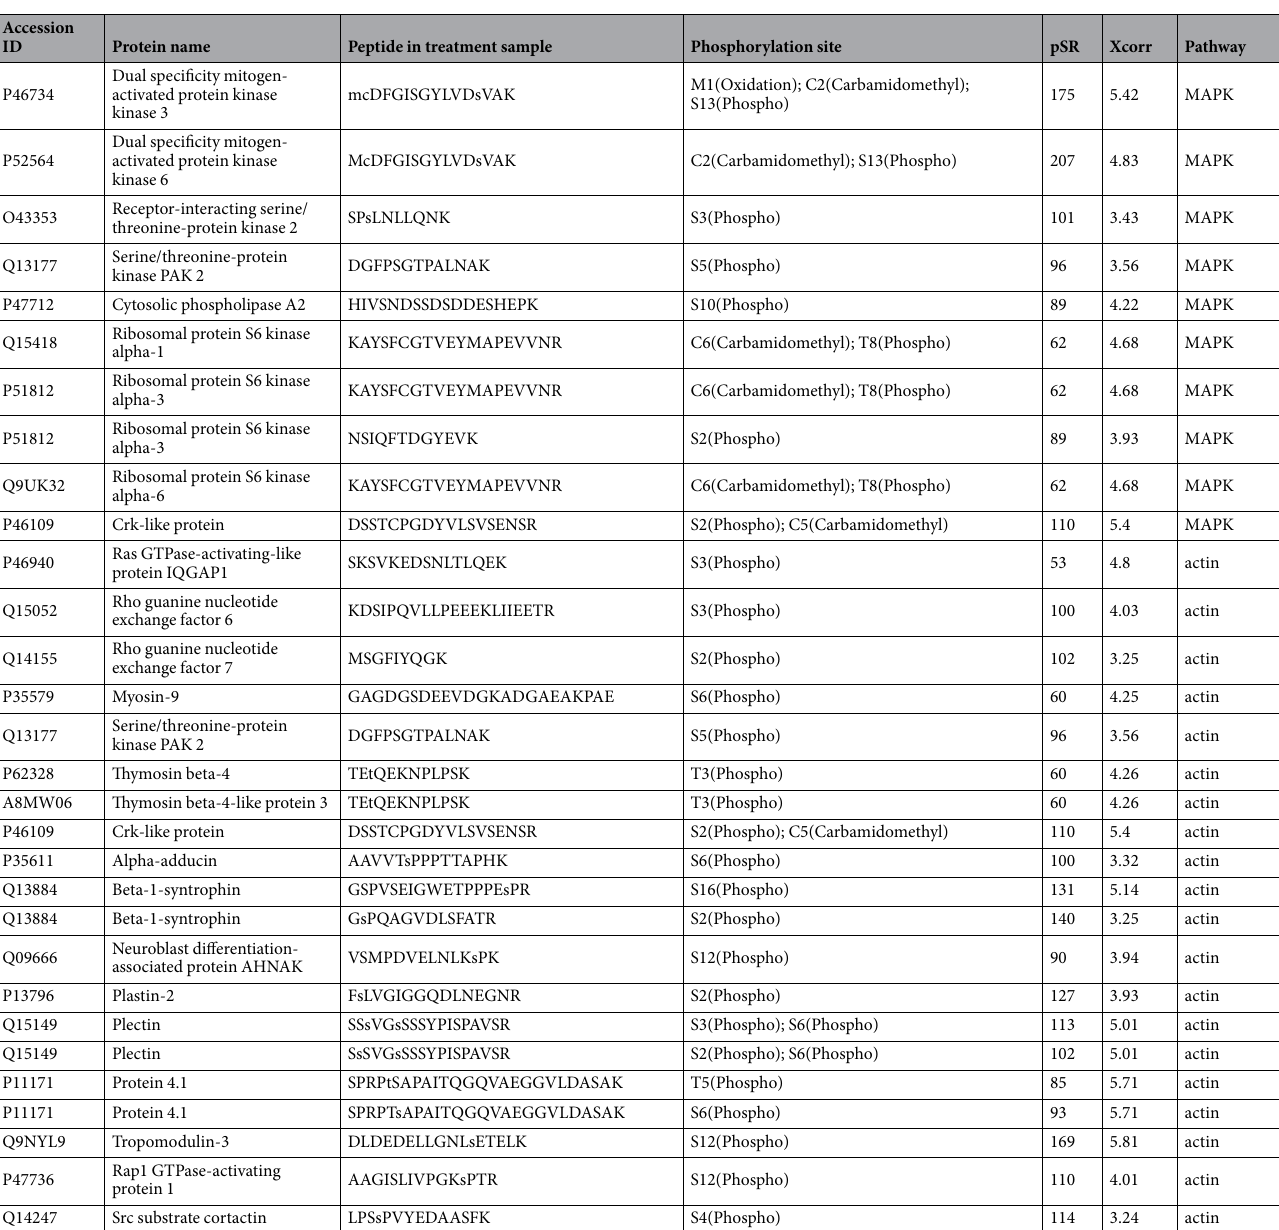
Table 1. MAPK and F-actin nucleation signaling molecules upon CCL2